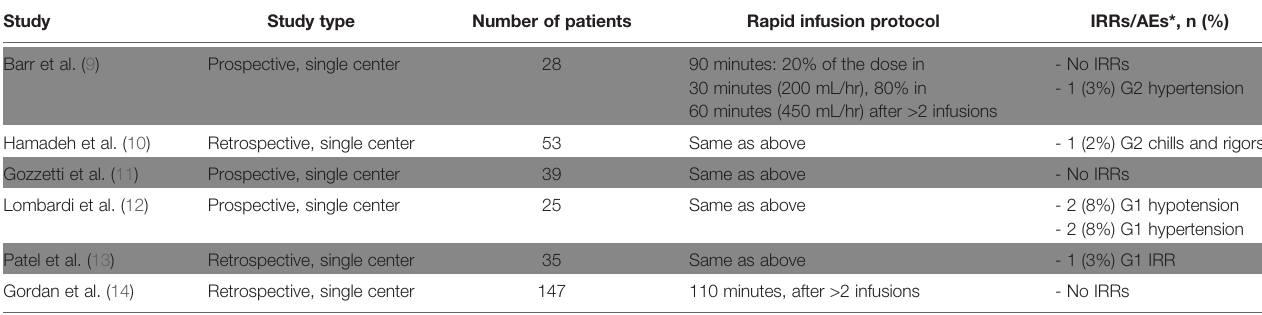
TABLE 4 | Summary of data from main studies on rapid daratumumab infusion. Study Study